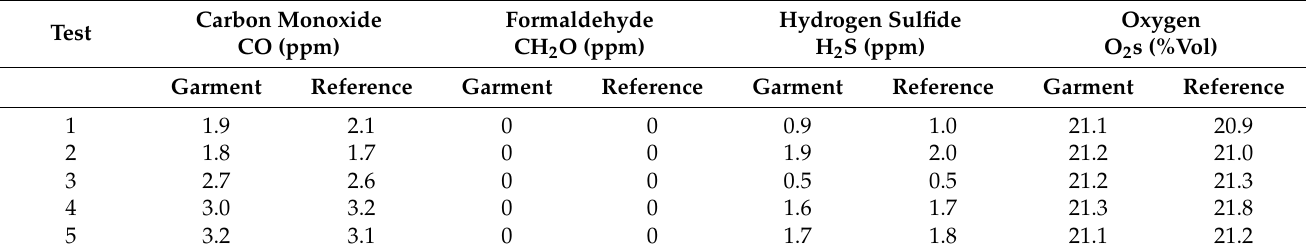
Table 4. Results of field tests carried out on the developed smart garment, comparing the acquired measurement with those provided by portable gas